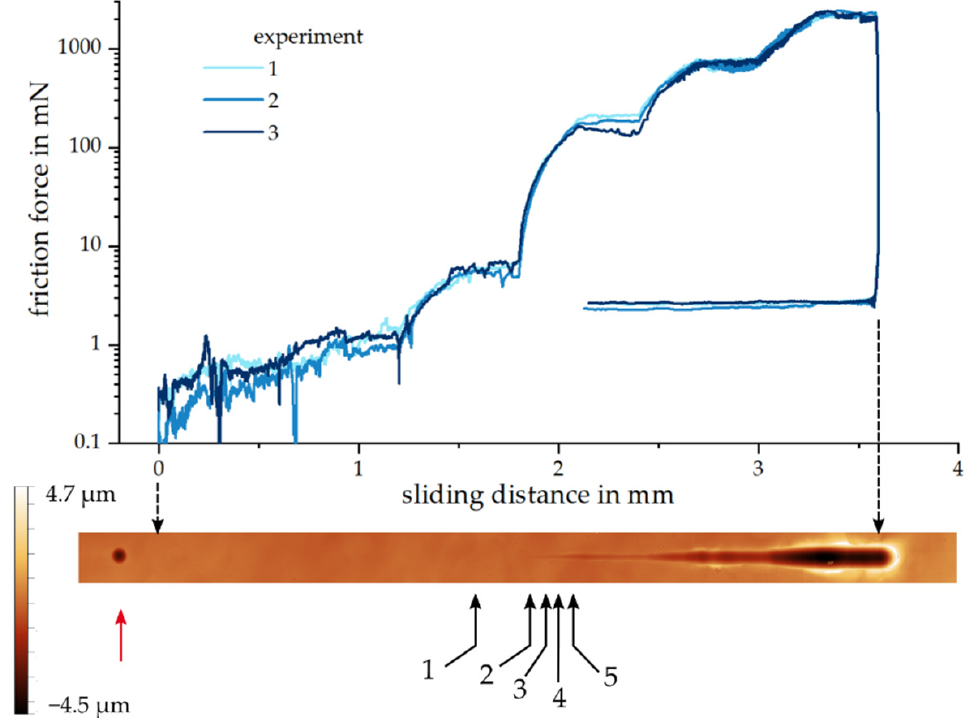
Figure 2. Friction force for all three experiments. The topography of the sliding trace for experiment 1 is visible in the bottom of the figure. The scale of the topography image corresponds to the graph abscissa. The numbered arrows indicate the positions of the line profiles shown in Figure 3. The red arrow marks the indent, which was made before the sliding experiment started.